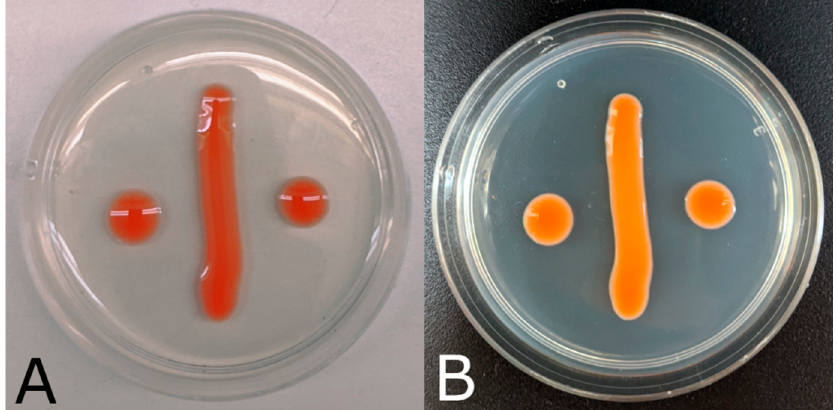
Figure 3. Sporobolomyces lactucae . ( A ) Morphology of S. lactucae after 7-day incubation at ambient conditions on PDA, photographed against a white background. ( B ) The same plate photographed against a black